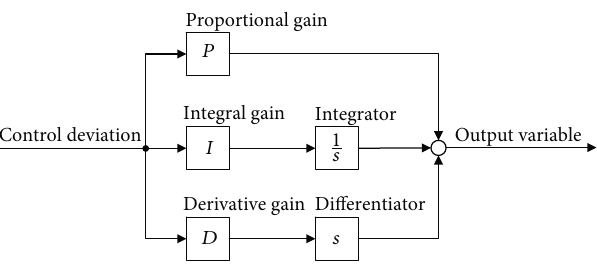
Figure 6: Structure of the PID controller in the frequency domain. The controller is set using the parameters P , I , and D .